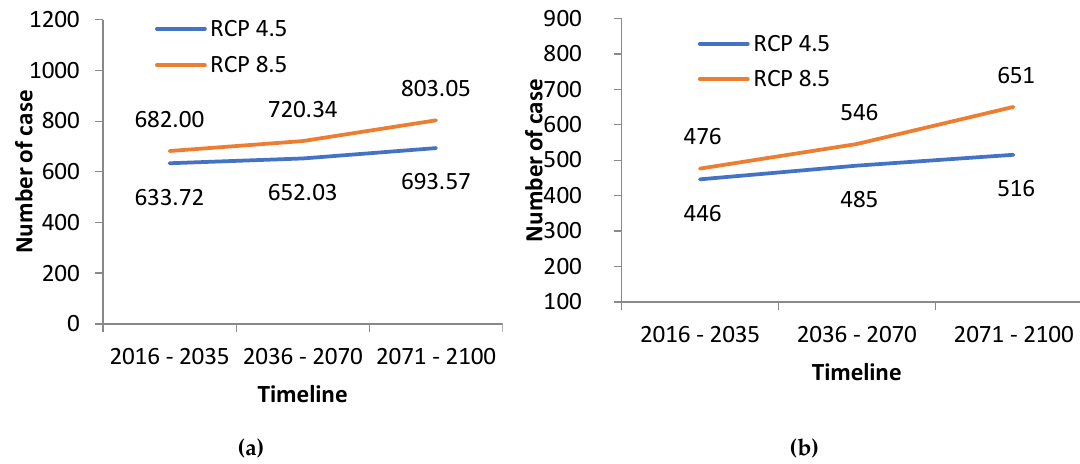
Figure 6. Projected trends of ( a ) ARI in Farafangana and ( b ) Diarrhea in Antsiranana.